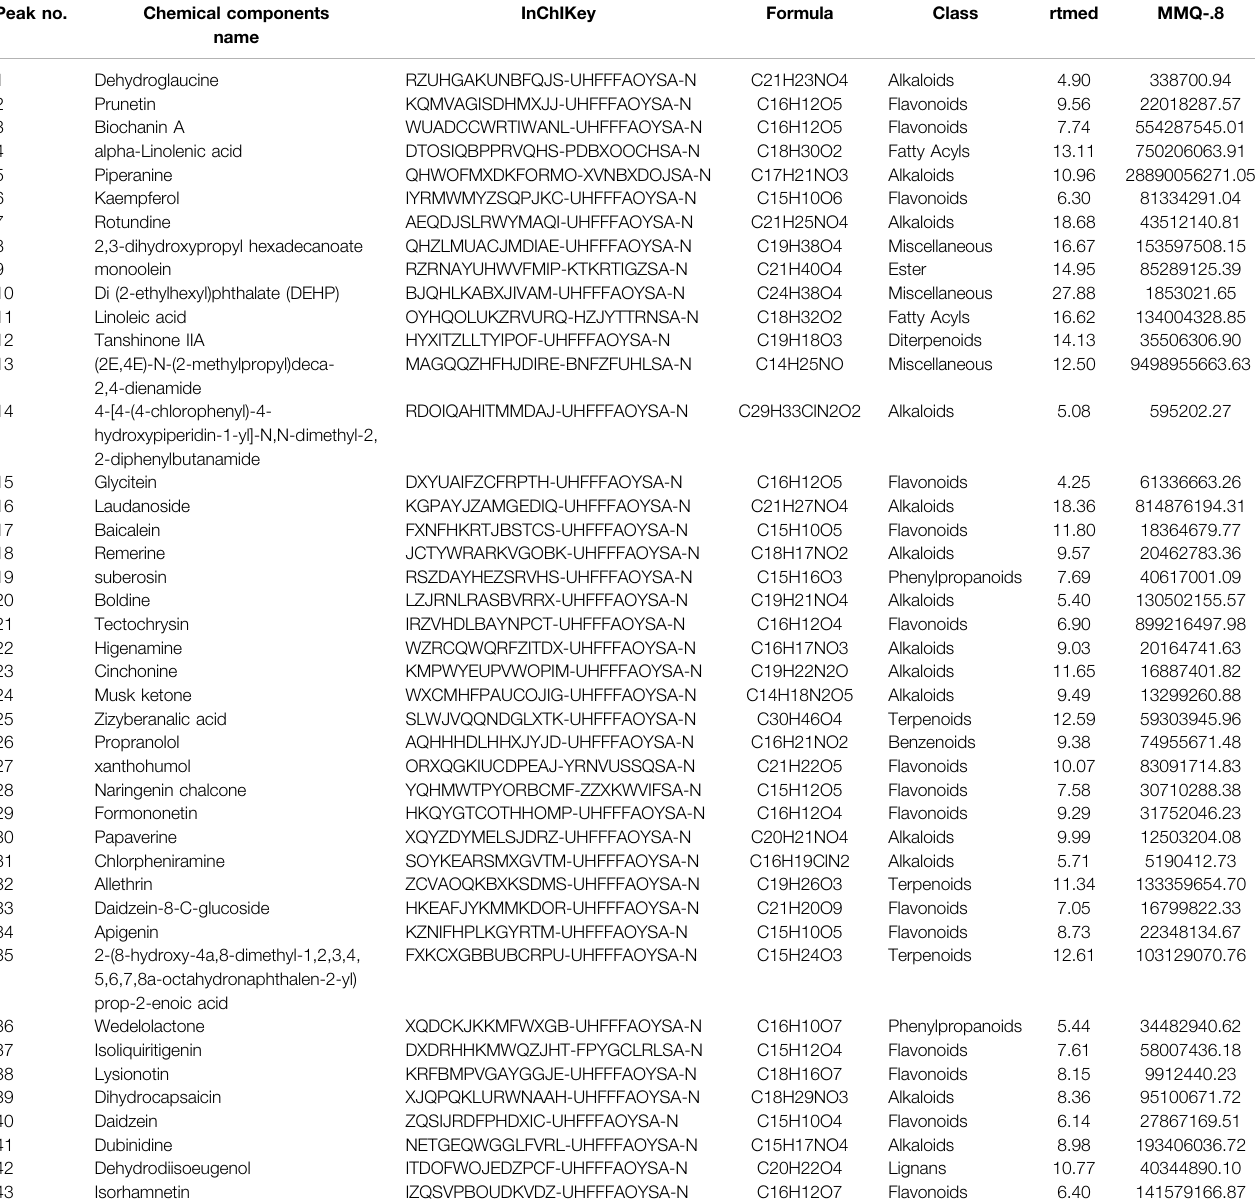
TABLE 4 | Forty-three MMQ-8 active metabolites have been detected in POS electrospray ionization modes of UHPLC-QE-MS assay and screened by the Percent Human Oral Absorption and drug-likeness values. Peak